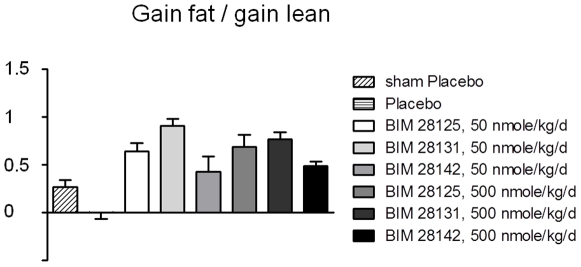
Ratio of fat and lean gain induced by ghrelin compounds.A ratio of 1 means equal fat and lean body mass gain. BIM-28131 (50 nmole/kg/d) has the most benificial ratio of all compounds and doses tested.